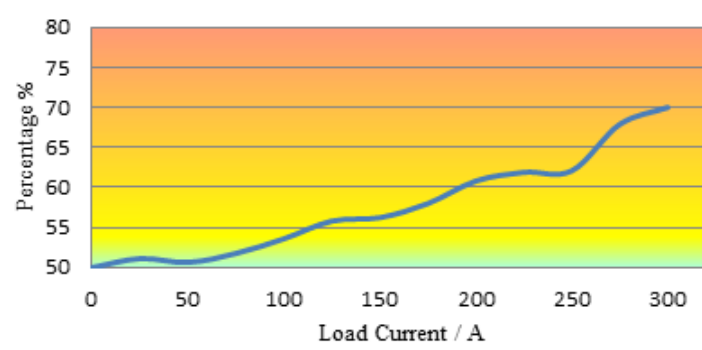
Figure 7: Service status on temperature with respect to the current applied as per Table 4.